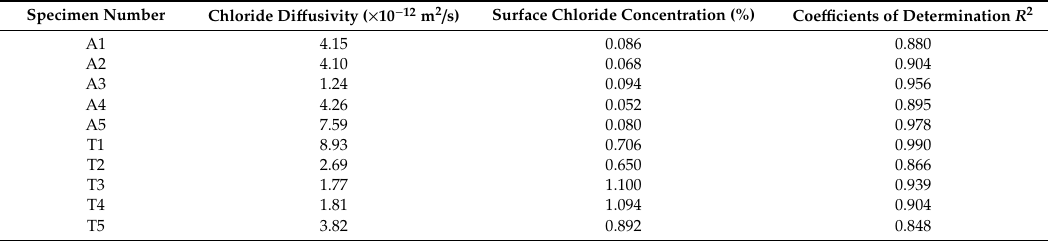
Table 2. Estimated chloride di ff usivity and surface chloride